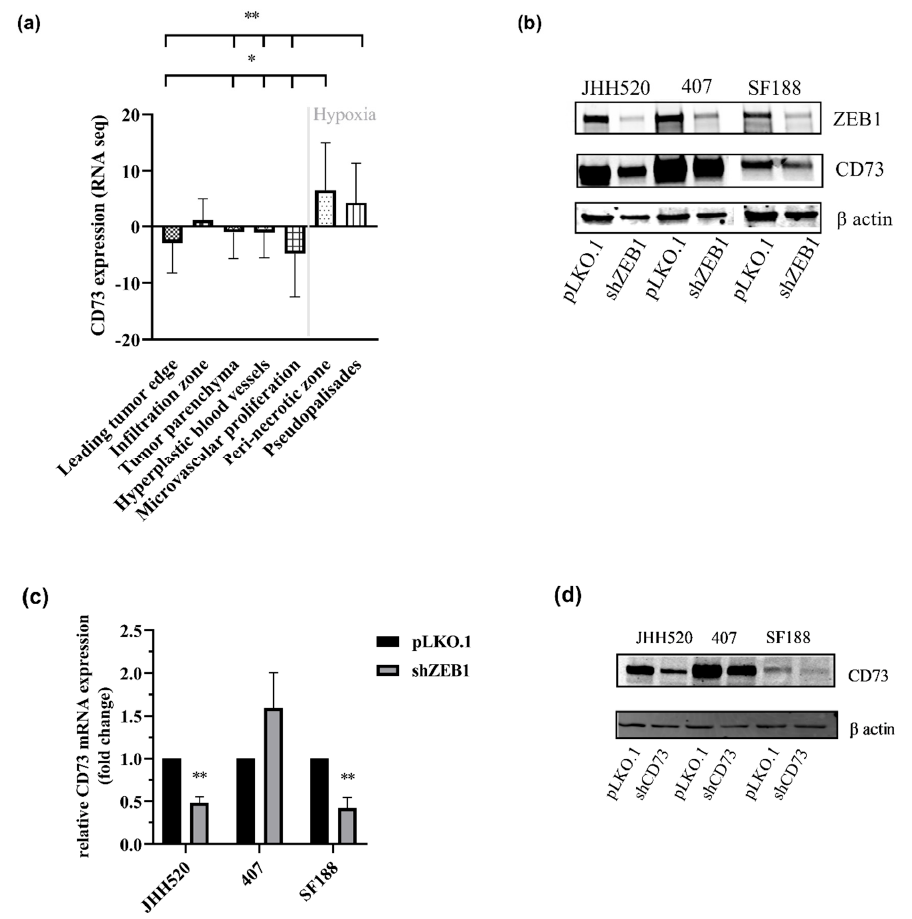
Figure 1 . CD73 increases in hypoxia and is regulated by epithelial-to-mesenchymal-like transition (EMT). ( a ) mRNA expression data were retrieved from the IVY Glioblastoma project and analysed for CD73 expression ( n = 55 samples). CD73 mRNA was increased in the hypoxic pseudopalisades